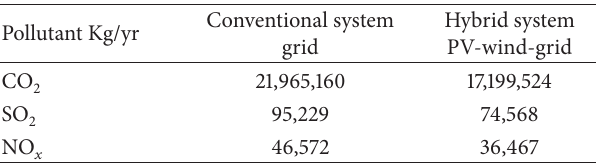
Table 2: Emissions comparison between a standard system (grid) and a hybrid system